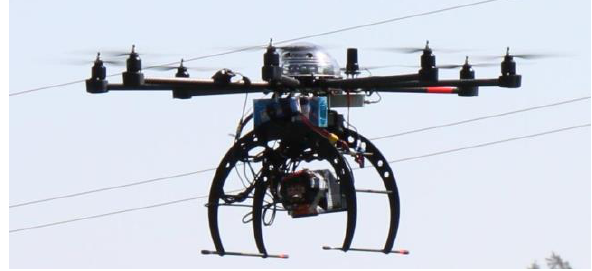
Figure 2. Mikrokopter UAV with the spectral camera.